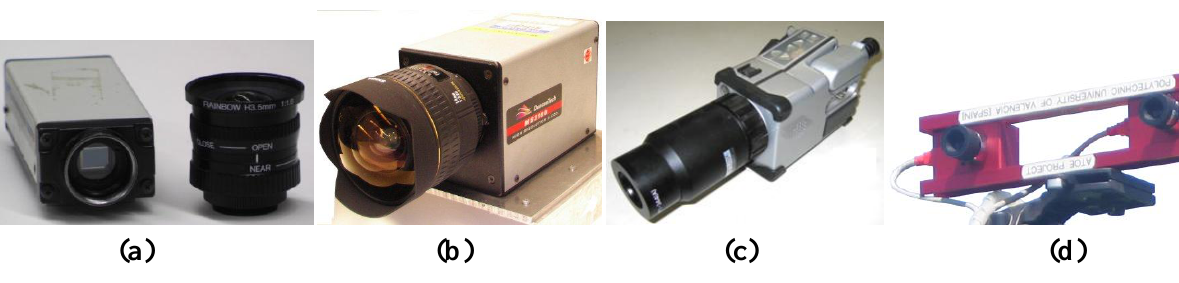
Figure 5. Main visual perception sensors for agricultural vehicles : (a) Monocular camera.